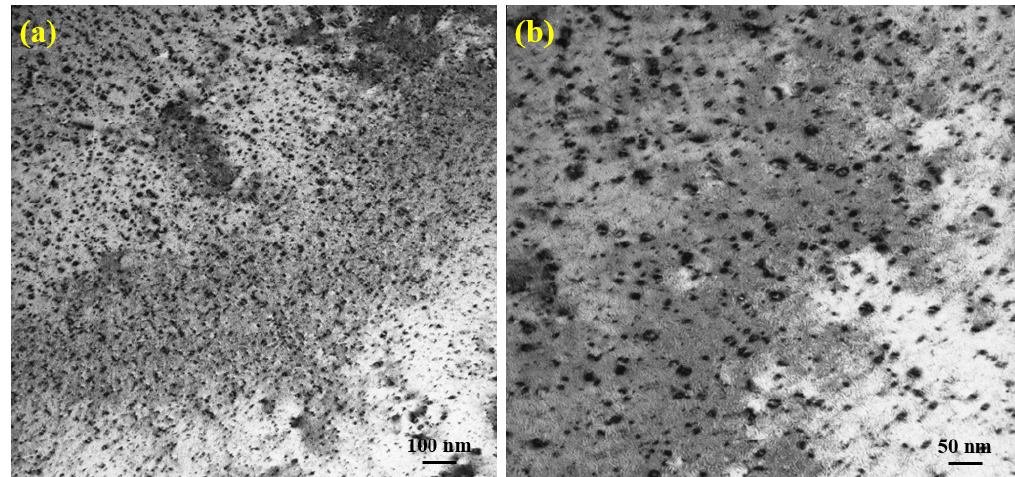
Figure 4. Microstructure changes of Fe9Cr alloy irradiated with deuterium at 5 × 10 16 D/cm 2 . ( a ) Low magnification. ( b ) High magnification.